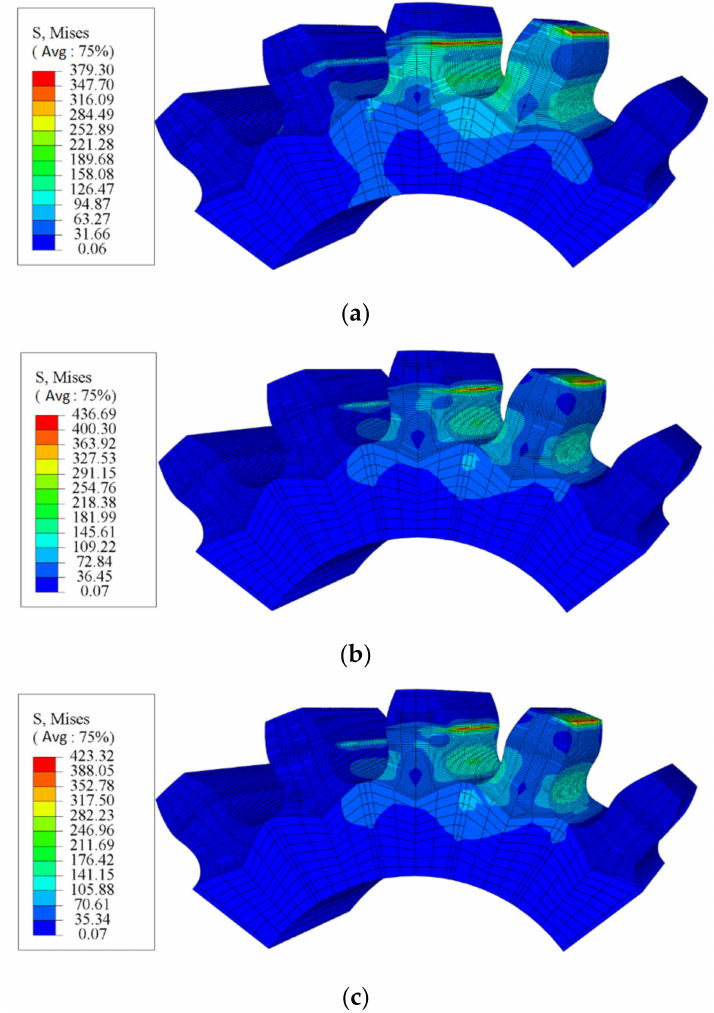
Figure 15. Comparison of tooth surface load distribution at the pitch circle position. ( a ) Unmodified; ( b ) Modified values y 1 = y 2 = 8 µ m and y 3 = 0; ( c ) Modified values y 1 = y 2 = 8 µ m and y 3 = 8